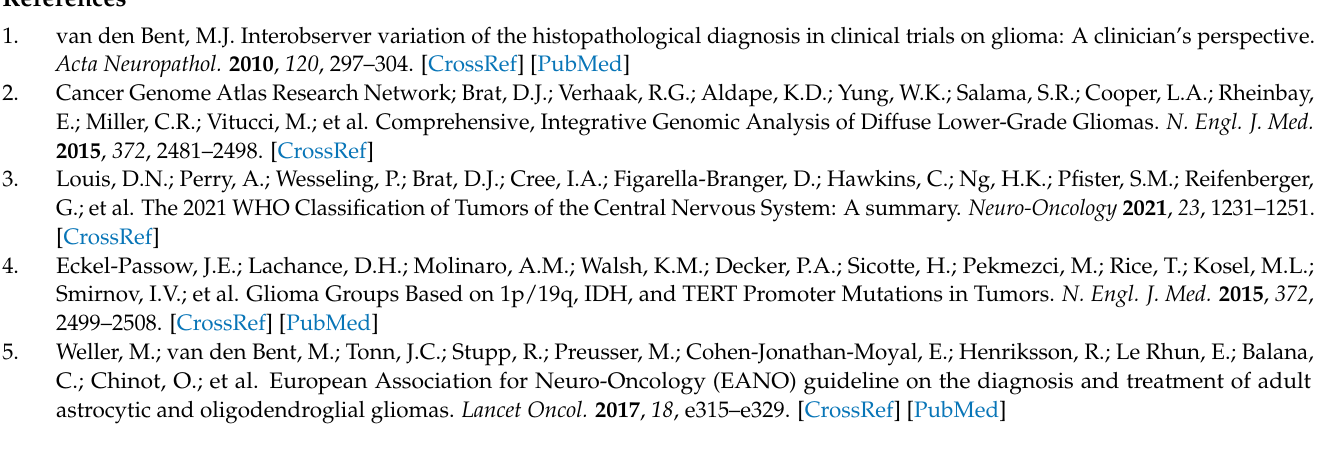
Figure S2: Train and loss curve of final selected model; Table S1: Imaging parameters of MRI acquisition